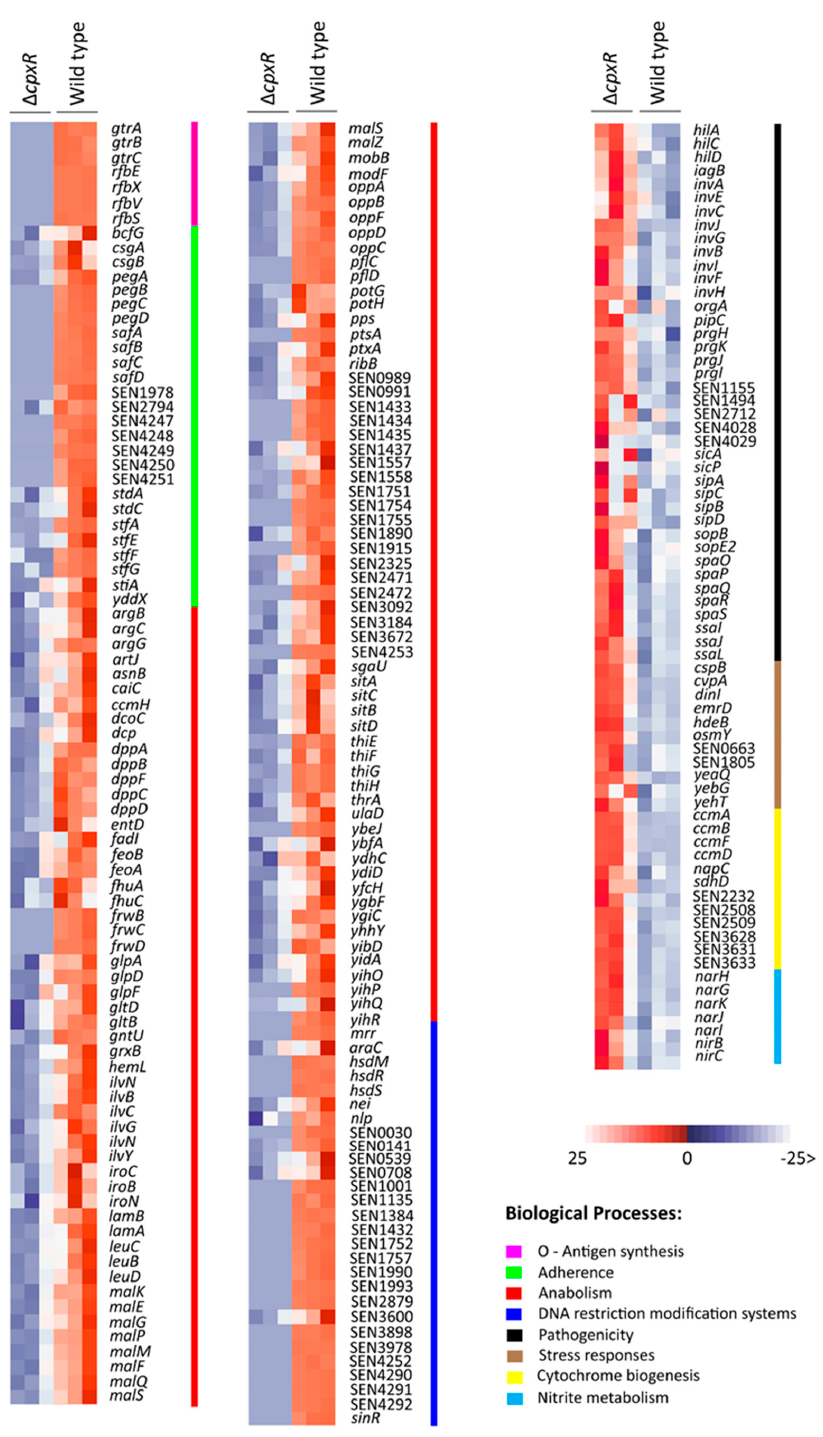
Figure 7. Transcriptional profile of the ∆ cpxR biofilm relative to its wild-type parental counterpart. RNA was isolated from the 48 h wild-type and ∆ cpxR mutant strains biofilms. The transcriptomic profiles were determined using a HiSeq 4000 PE100 Illumina platform. A heat map depicting the most impacted (i.e., based on number of genes, level of expression and functional significance to sessile lifestyle) functionally-associated groups of significantly di ff erentially expressed genes (SDEGs) is provided. Each SDEG had to satisfy two criteria: (1) a minimum 2- fold change, and (2) a false discovery rate (FDR) of p < 0.05. The intensity of the red and blue colors indicates the fold change in gene expression. Alongside the heat maps are included color-coded lines, further indicating a ffi liation of SDEGs to di ff erent functional groups (e.g., biological